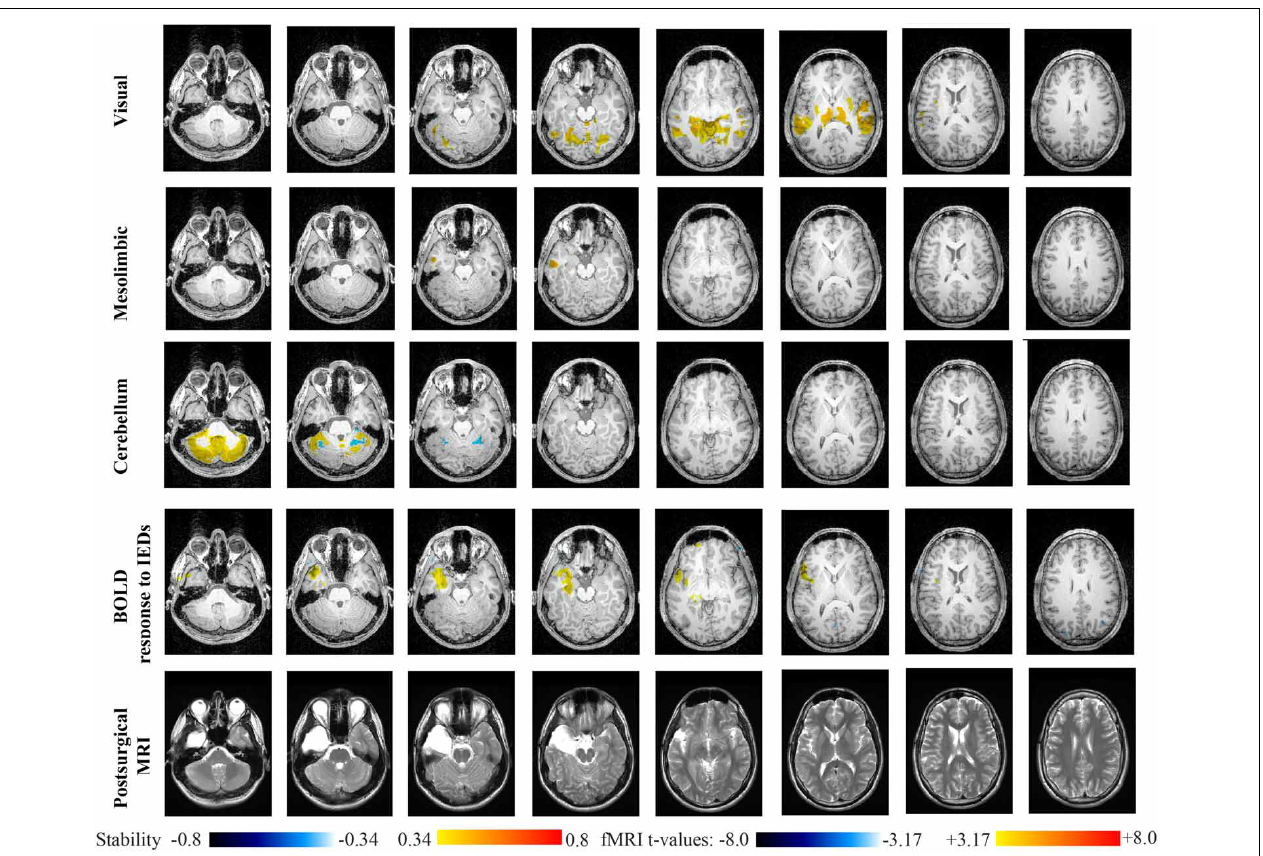
salient stability changes observed for Cmap n of Visual, Mesolimbic and Cerebellum networks are presented. The Visual and Cerebellum networks were also involved in significant interactions of modularity changes at p < 0 . 001. Same colormap conventions than in Figure 6